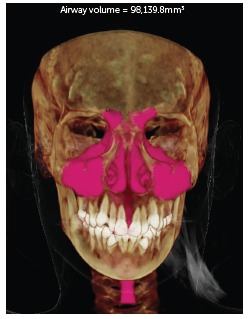
Total final volume.